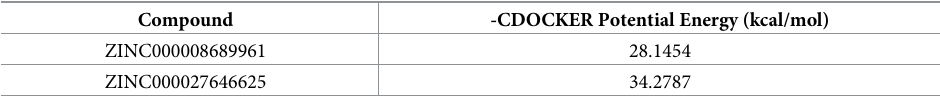
Table 4. CDOCKER potential energy of compounds with